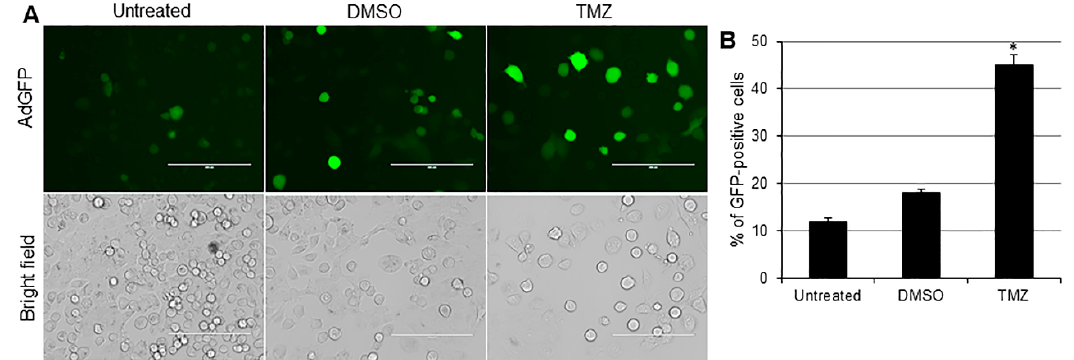
Figure 3. Temozolomide (TMZ) facilitates adenovirus entry into triple-negative breast cancer (TNBC) cells: ( A ) HCC1937 cells were infected with adenovirus expressing green fluorescent protein (AdGFP) at a multiplicity of infection concentration of 5 alone or in combination with TMZ (0.4 mM) or vehicle dimethyl sulfoxide (DMSO). Expression of GFP was evaluated by fluorescence microscopy. Scale: 200 µm. ( B ) Percentage of GFP-positive cells calculated relative to number of cells in the field. Results represent the mean of three repeated measurements ± standard deviation (SD; error bars) (* p < 0.05).